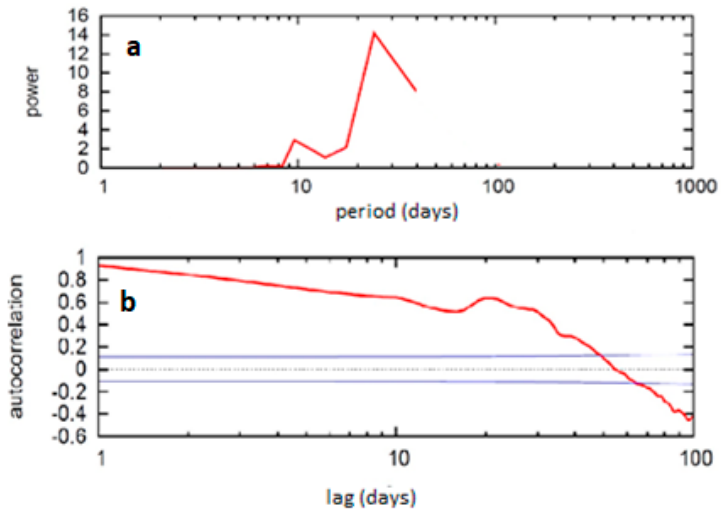
Figure 4. The control model run (IPSL-CM5) for ( a ) IE band passed (5–40 day) FFT power spectra (ordinate) versus spectral period (days—abscissa) (top), and ( b ) the autocorrelation of the IE diagnostic (ordinate), where the lag is presented in days (abscissa). The blue dashed line is the zero correlation line, and the solid line is the 95% confidence level.